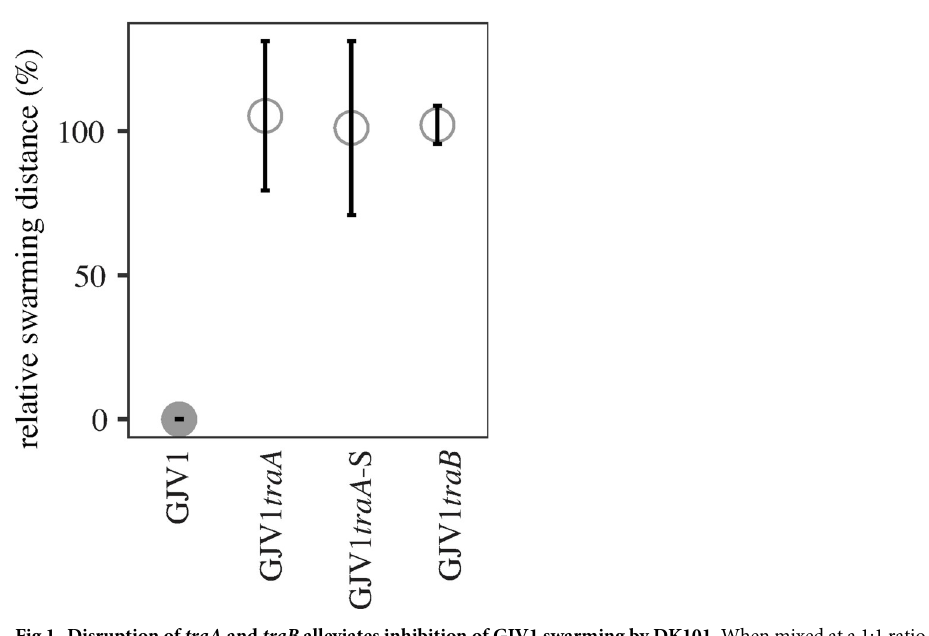
Fig 1. Disruption of traA and traB alleviates inhibition of GJV1 swarming by DK101. When mixed at a 1:1 ratio, DK101 inhibits swarming by GJV1 but not GJV1 traA , GJV1 traA -S or GJV1 traB . y- axis values indicate the percentage- distance swarmed by each focal strain indicated on the x axis in mixture with DK101 relative to its swarming distance in pure culture (see Methods for details). Error bars are 95% confidence intervals, n = 3 replicates.